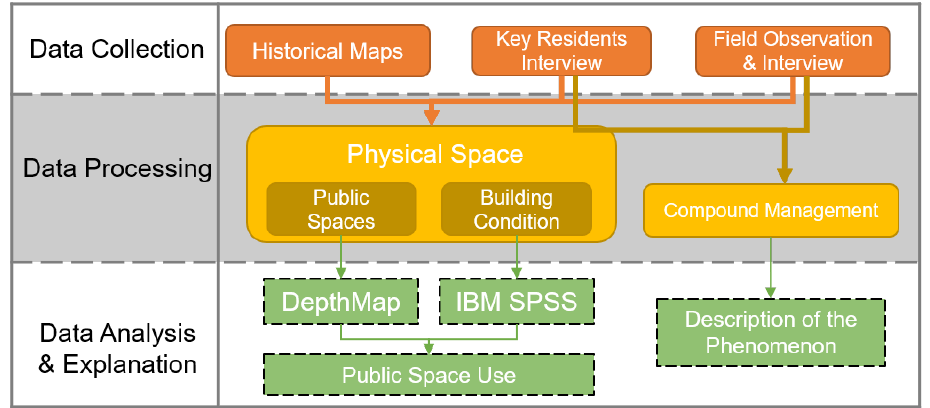
Figure 5. Study’s